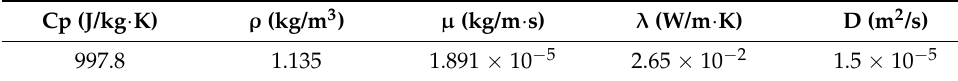
Table 1. Properties of the air-CO 2